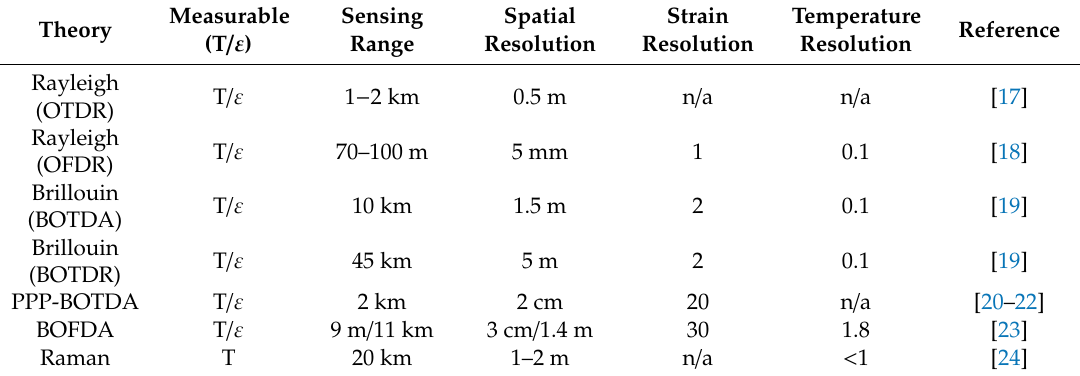
Table 1. Comparison between different kinds of distributed fiber optic sensing systems.